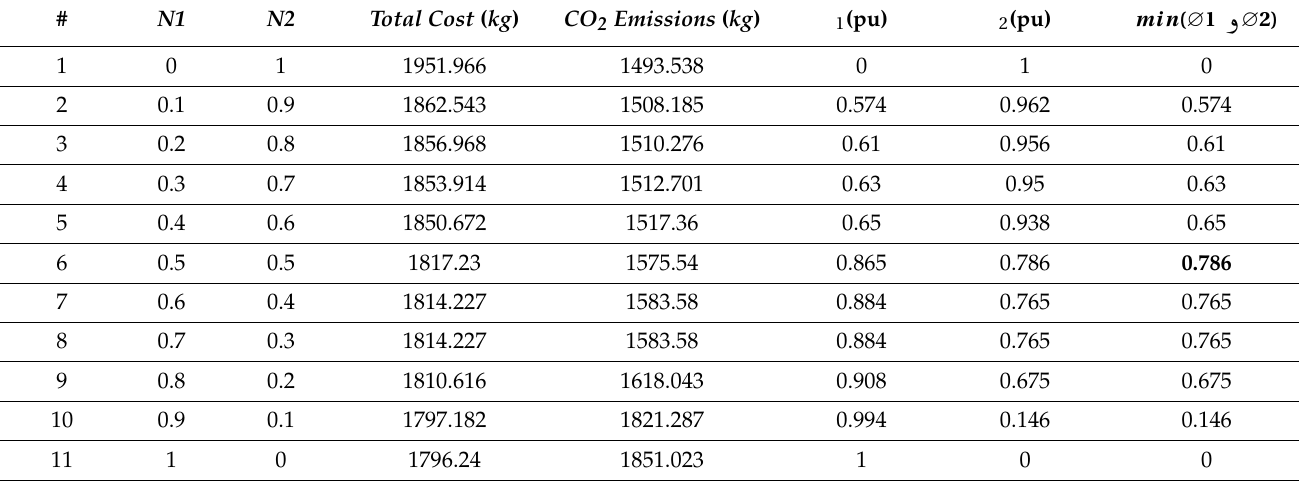
Table 6. Pareto optimal solutions for scenario